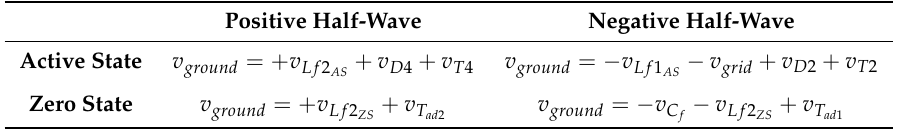
Table 1. Summary of ground voltage depending on the modulation states and output